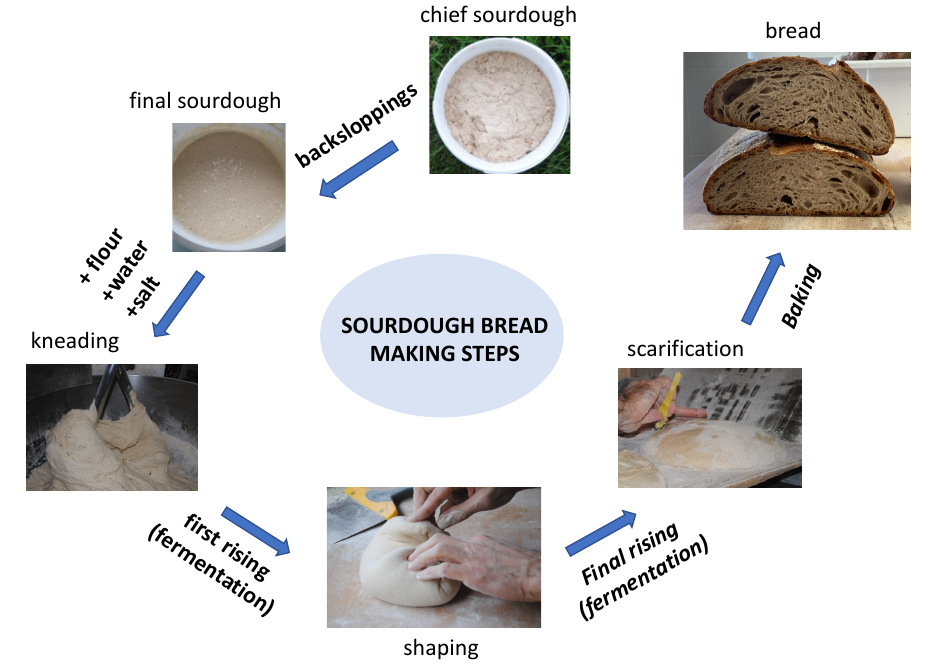
Figure 1: The sourdough bread making process. Sourdough is a mix of flour and water naturally fermented by bacteria and yeasts. It is initiated by mixing flour, water and occasionally other ingredients. It is then “fed” by regularly adding flour and water, a process termed back-slopping. Once considered mature by bakers based on their acidity, flavour and bubbling activity, the sourdough is called "chief", or “mother” sourdough, and can then be used for bread making. The bread making process starts from this “chief sourdough”, or from a piece of dough or sourdough sampled from the preceding bread making process, or initiated from a mix of flour and water naturally colonized by yeasts and lactic acid bacteria following several back-sloppings. Once or several times, the chief sourdough is refreshed by adding flour and water to constitute the final sourdough, which is used for bread making. This final sourdough is mixed with flour, water, and other ingredients (salt, seeds, yeasts starters, etc.) during kneading to constitute the dough. After kneading, primary fermentation occurs during the first rising. The dough is then divided and shaped. The pieces of dough are then left to rise during a second fermentation and finally